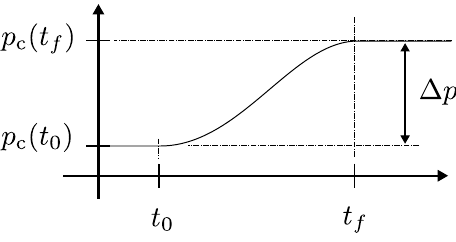
Figure 8. Illustration of pressure shift in a single cylinder chamber.